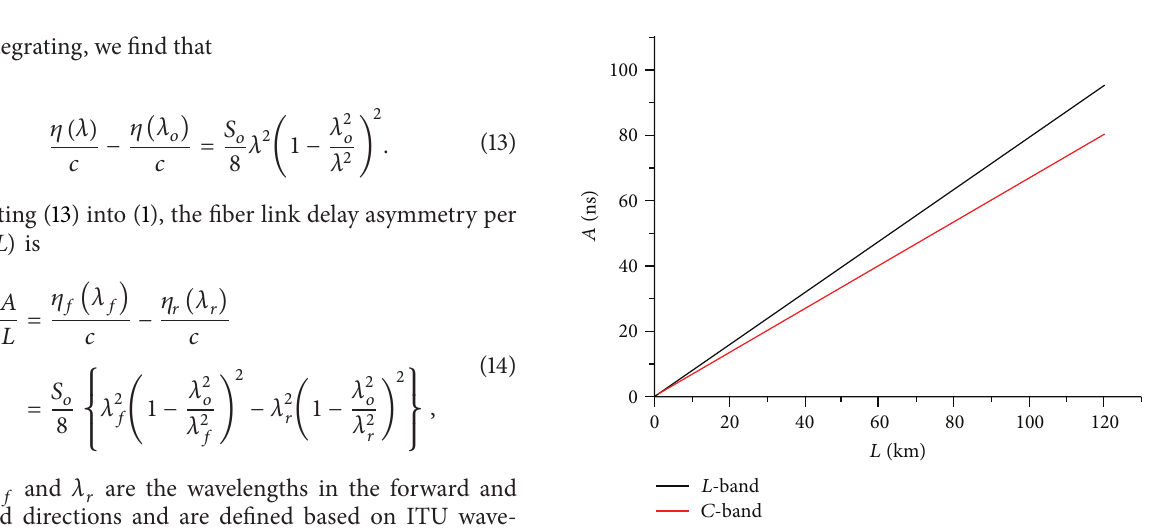
Figure 7: Fiber link delay asymmetry 𝐴(𝜆) versus transmission distance 𝐿( km ) , where {𝜆 𝑓 = 1569 nm, 𝜆 𝑟 = 1530 nm } in C -band and {𝜆 𝑓 = 1610 nm, 𝜆 𝑟 = 1570 nm } in L